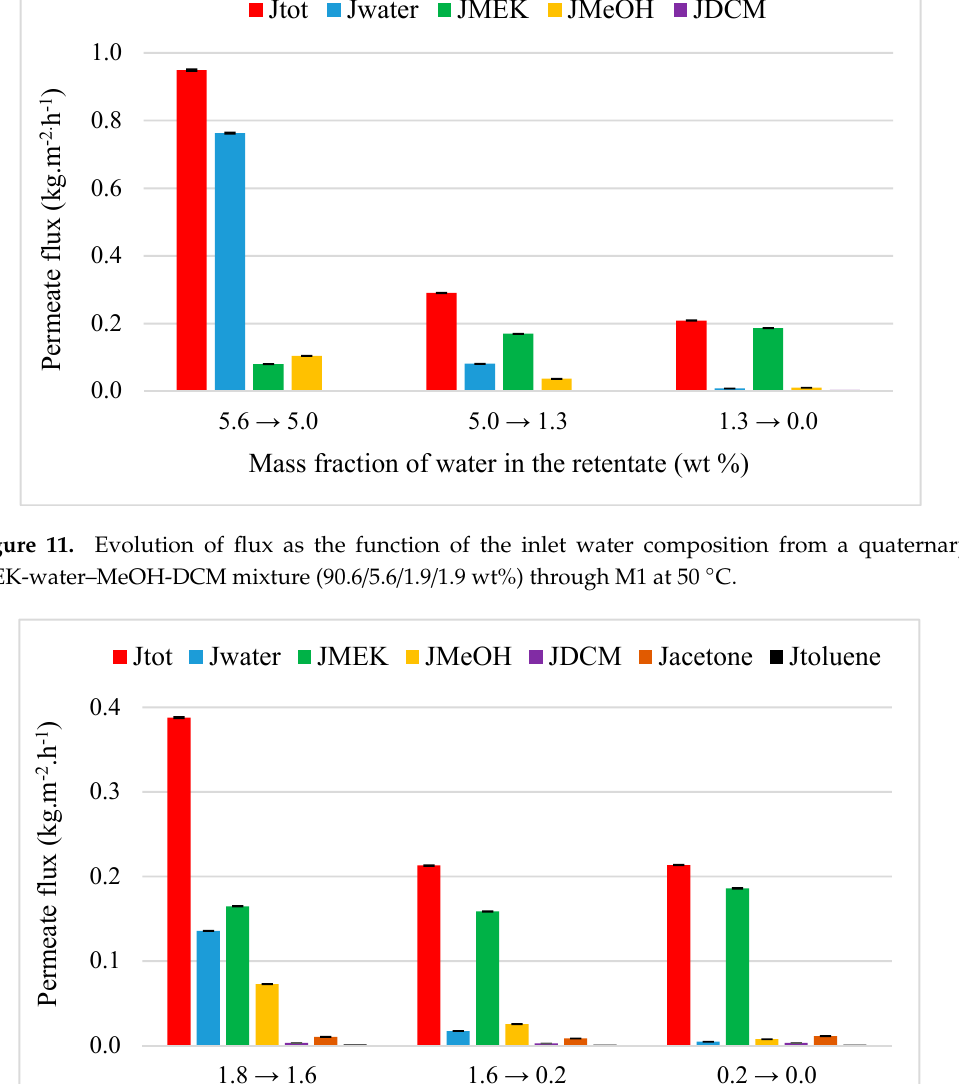
Figure 12. Evolution of flux as the function of the inlet water composition from a multi-component MEK-water–MeOH-DCM-acetone-toluene mixture (90/2.0/2.0/2.0/2.0/2.0 wt%) through M1 at 50 °C. Table 2. Summary of operational conditions for dehydration and purification